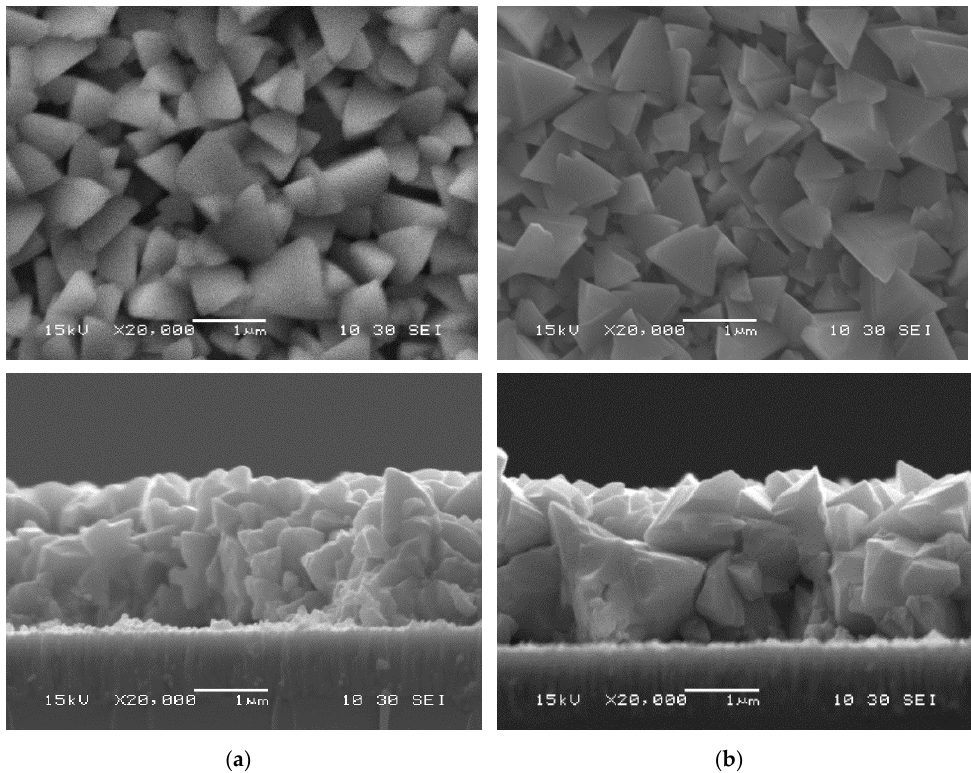
Figure 4. Scanning electron microscopy photographs of CIGS films comparing recrystallization in InBr 3 for 30 min at ( a ) 400 °C and ( b ) 500 °C.